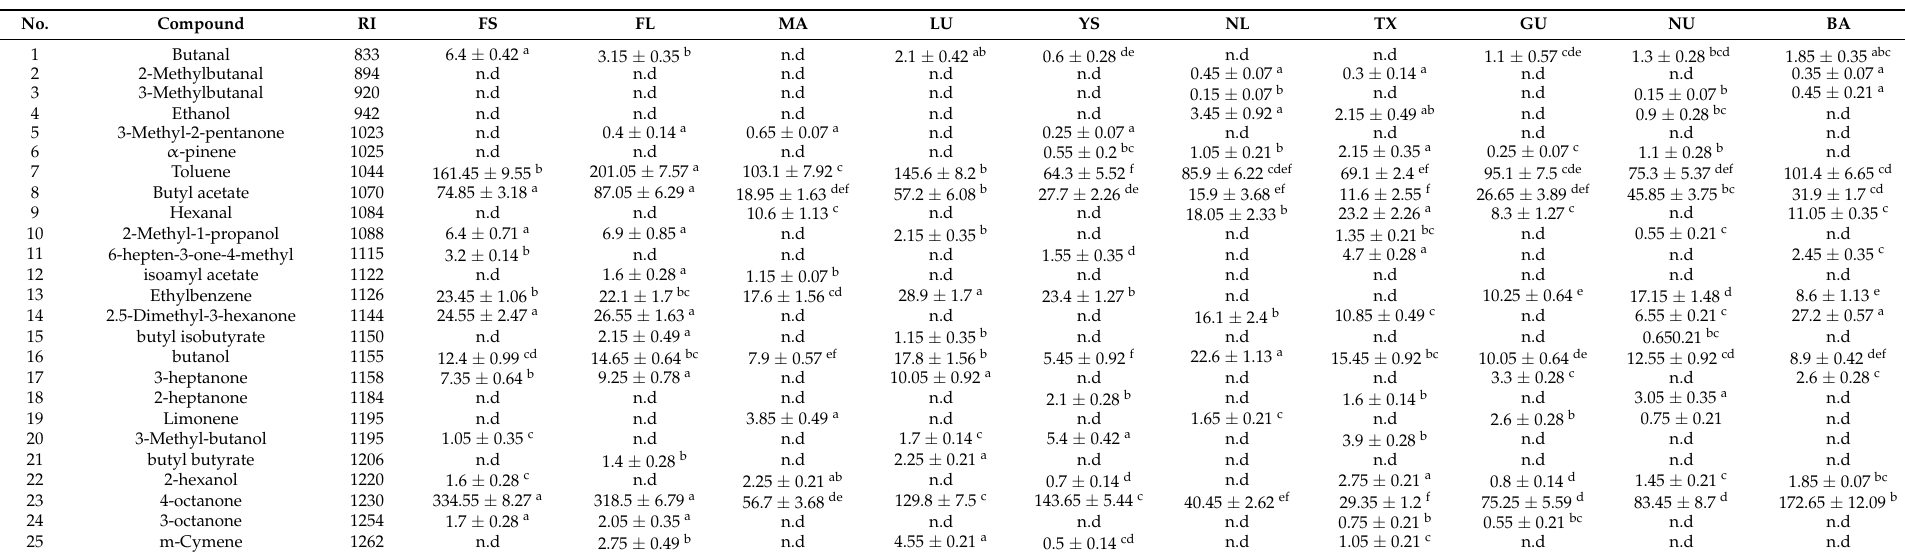
Table 4. Volatile profile of almond samples δ